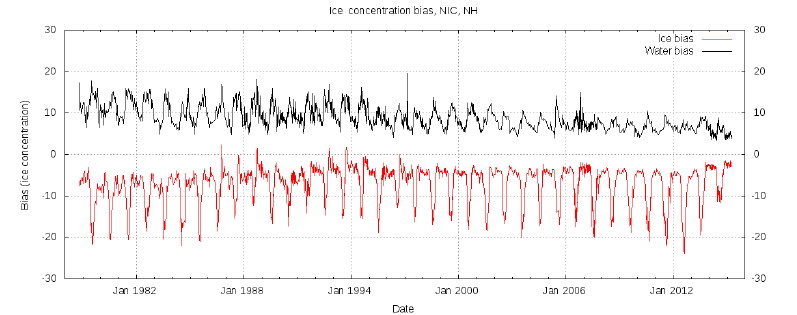
Figure 4. The Arctic ESICR–NIC ice chart mean difference (bias) for areas of ice in red and for areas of open water in black.